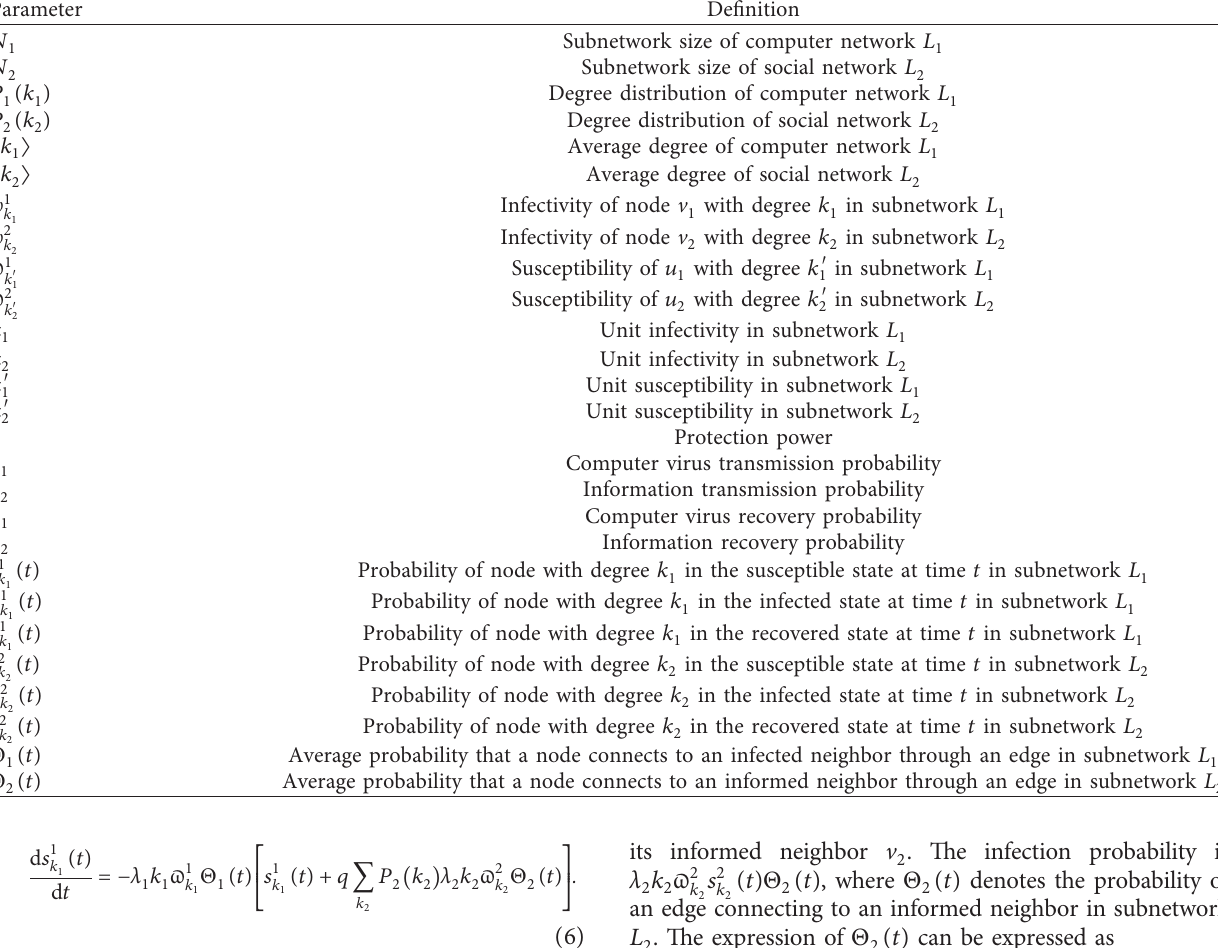
Table 1: Definitions of parameters and